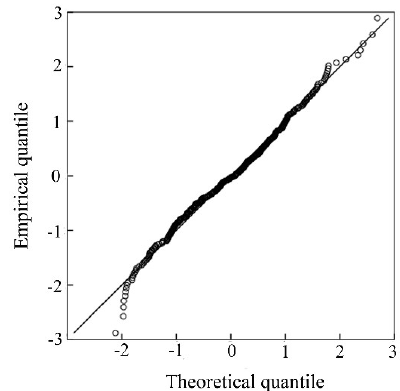
Figure 3. The normal distribution Q-Q plot of terrestrial water storage.